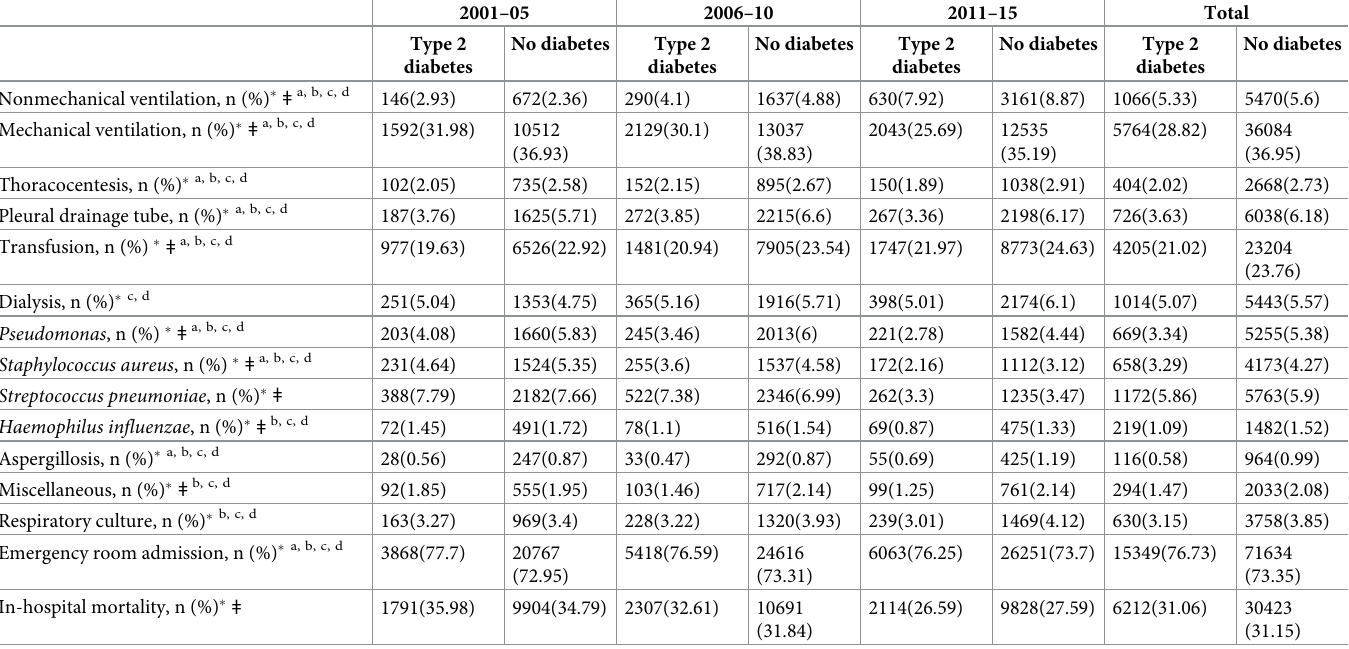
Table 2. Procedures, hospital outcomes and isolated pathogens of hospitalized patients who suffered from postsurgical pneumonia in Spain from 2010 to 2015 according to diabetes